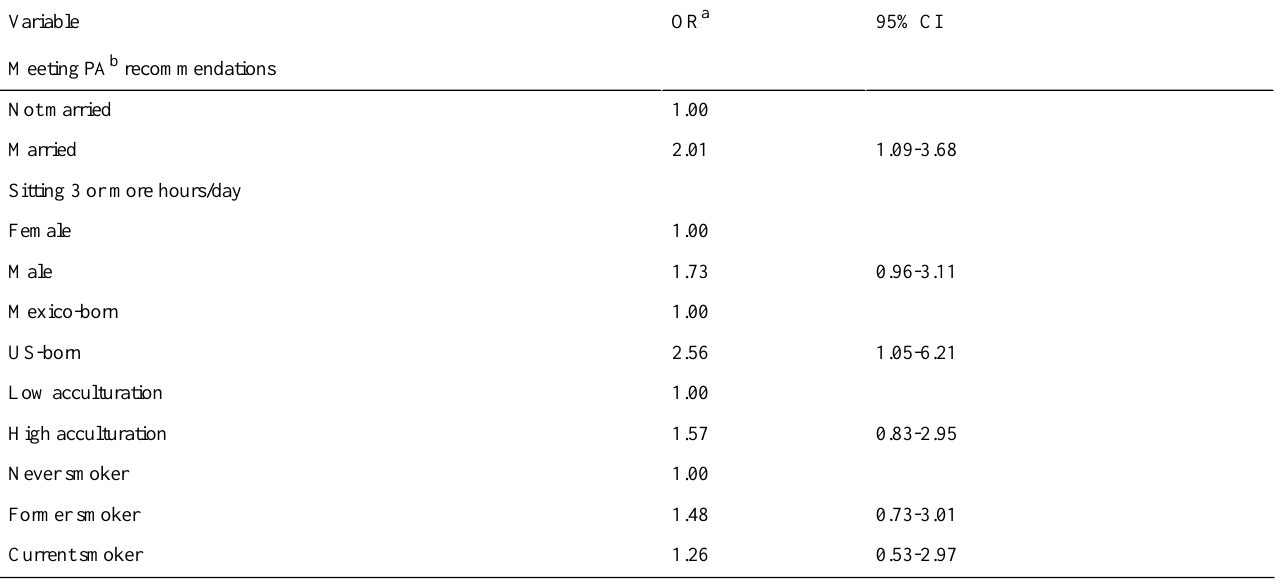
Table 5. Multivariate adjusted odds ratios (95% CI) of mobile phone nonusers for meeting physical activity recommendations and sitting 3 or more